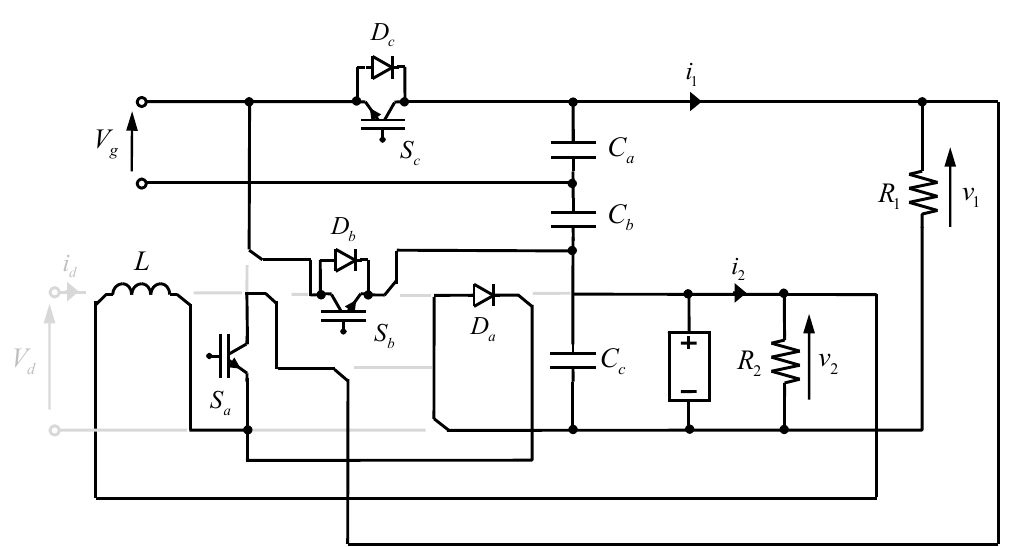
Figure 5. Buck-Rectifier